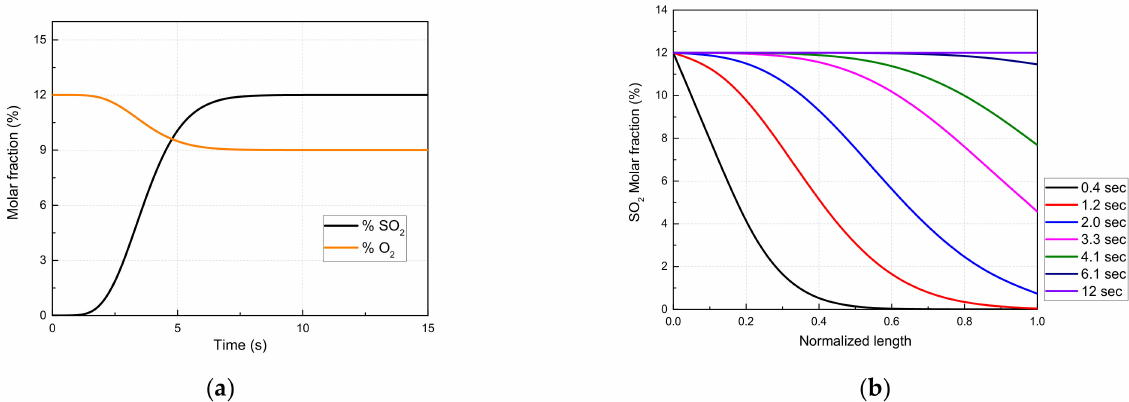
Figure 6. Dynamic response of the SO 2 molar fraction: ( a ) variation in the SO 2 molar fraction at the outlet of the combustion furnace; ( b ) SO 2 molar fraction evolution across the combustion